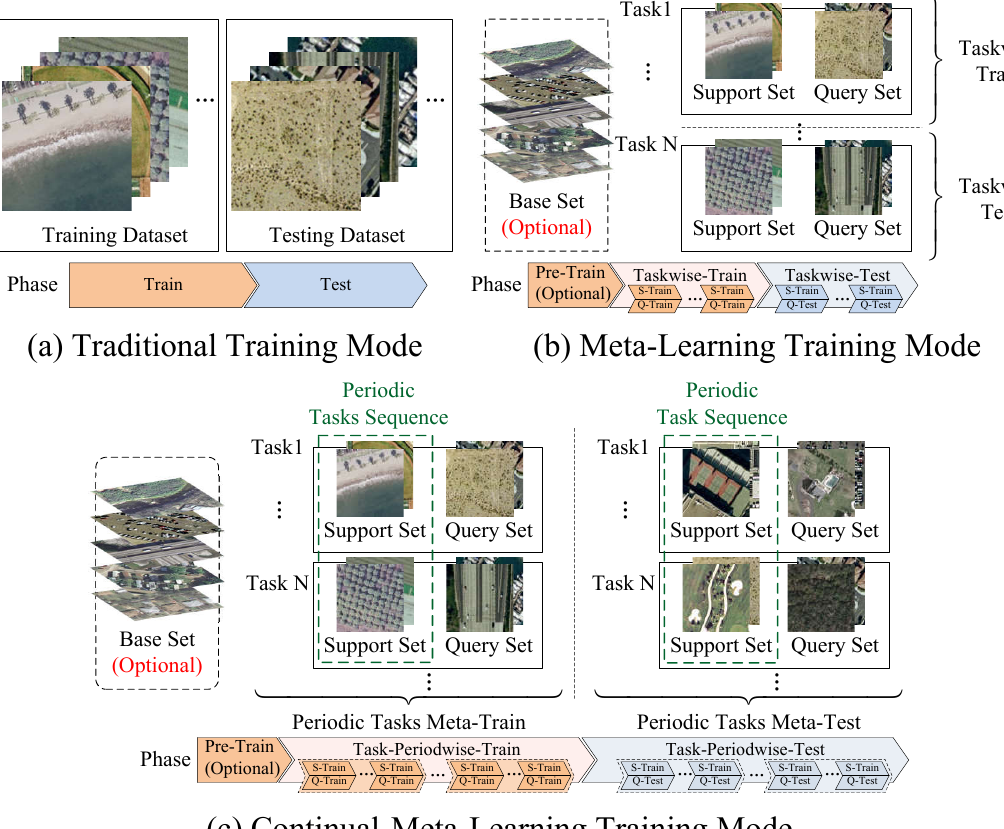
Figure 1. Illustrative comparisons of different training modes. ( a ) Traditional training mode, mono- lithic train and test periods. ( b ) The typical meta-learning training and testing in units of tasks. ( c ) The typical continual meta-learning training and testing procedure adopted in this